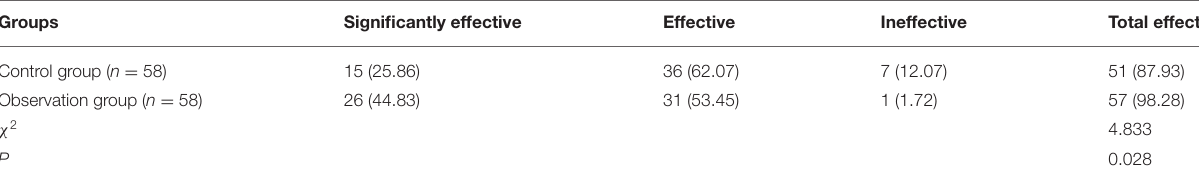
TABLE 1 | Comparison of clinical efficacy between the two groups of patients [ n (%)].